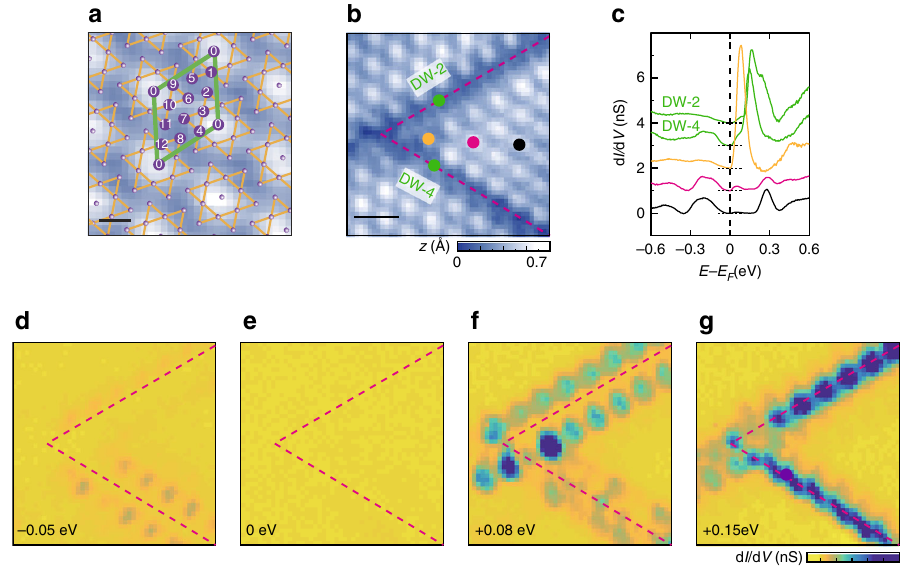
Fig. 1 Domain walls of 13-fold degenerate CDW reconstruction in 1 T -TaS 2 . a Constant current STM image of the commensurate CDW with a schematic view of the David-star ( orange lines ) reconstruction (sample bias voltage V s = − 1.20 V, tunneling current I t = 100 pA, and scan size L 2 = 3.4 × 3.4 nm 2 ). The violet spheres display the Ta atoms encapsulated by the S layers. The numbers in the CDW unit cell (a green parallelogram ) indicate possible center positions of the 13-fold degenerate David stars. The indices are given by the conventional sequence 19 . Scale bar , 0.5 nm. b A STM image of the junction composed from domain walls ( dashed lines ) ( V s = − 1.20 V, I t = 100 pA, and L 2 = 9.0 × 9.0 nm 2 ). Scale bar , 2 nm. c d I /d V spectra acquired at the position marked by same colored dots in b . Each curves are equally shifted in intensity for clarity. d – g Spatial distributions of the domain wall and edge states at the energies given in the fi